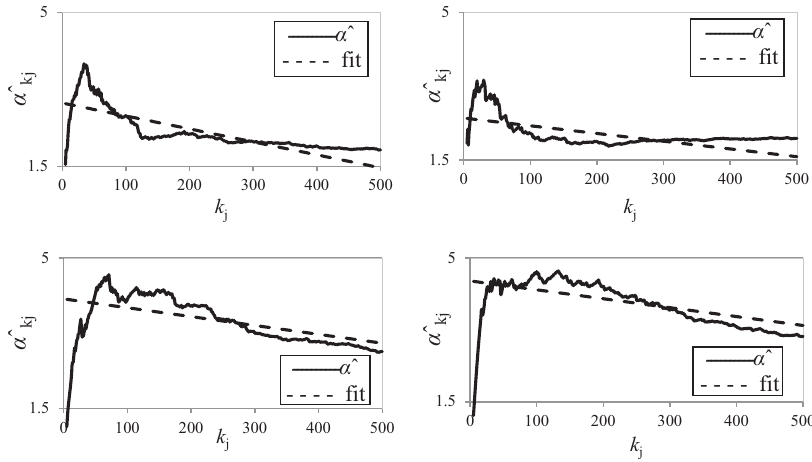
Figure 4. The estimated Hill tail index for the